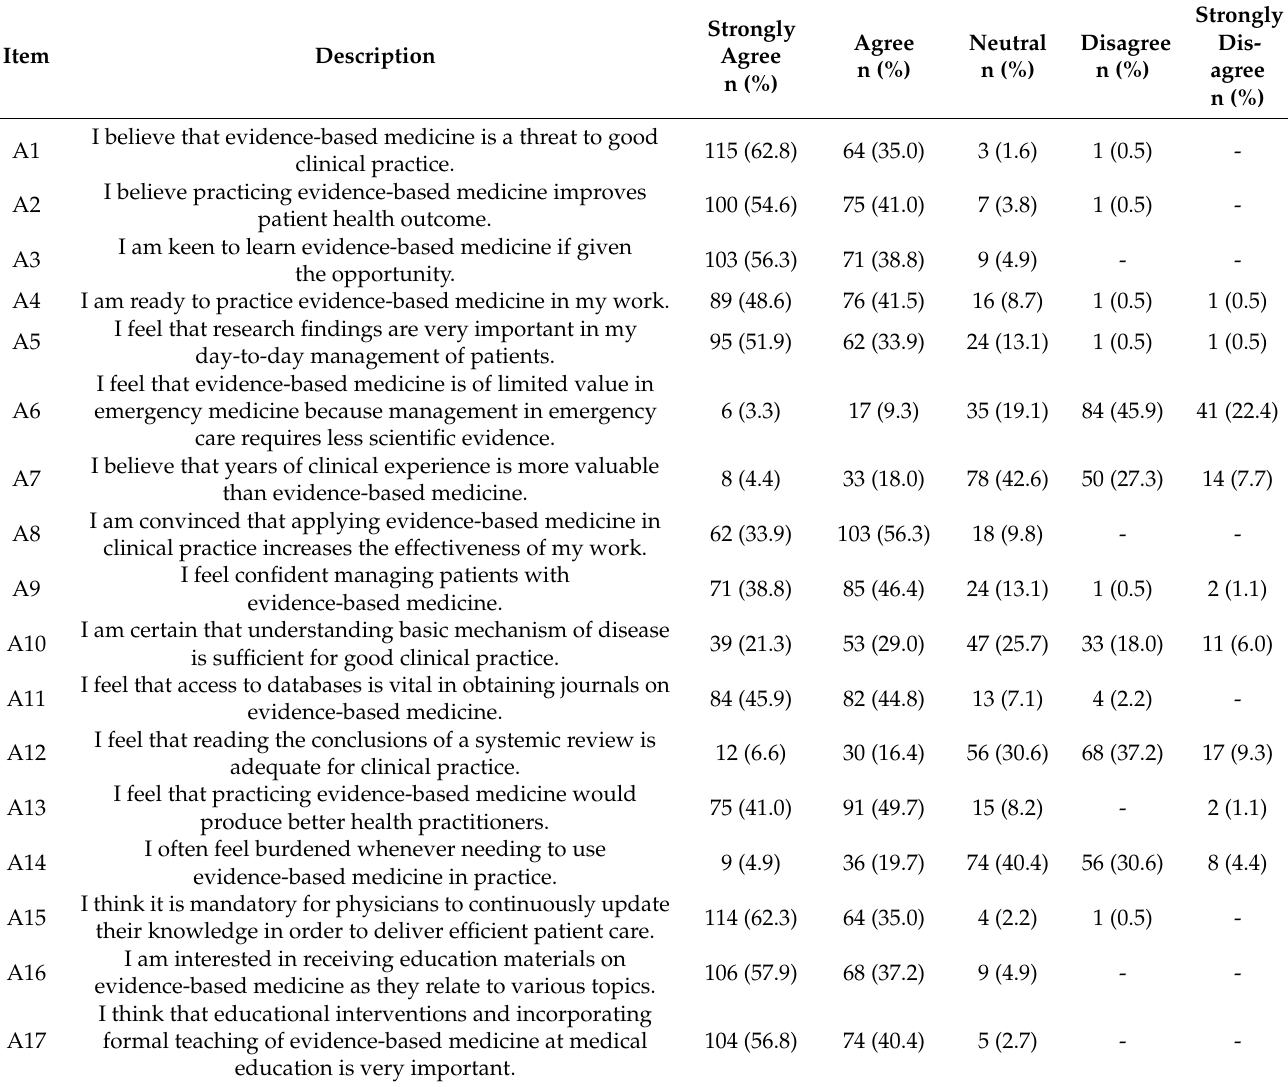
Table A2. Attitude toward Evidence-Based Medicine.